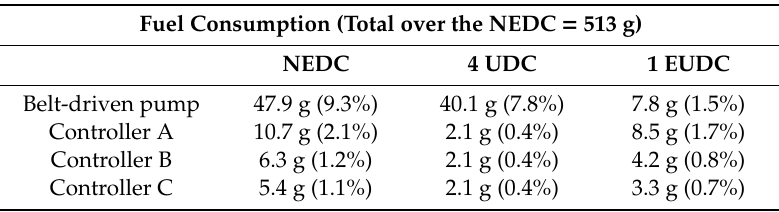
Table 4. Fuel consumption for pump actuation during the